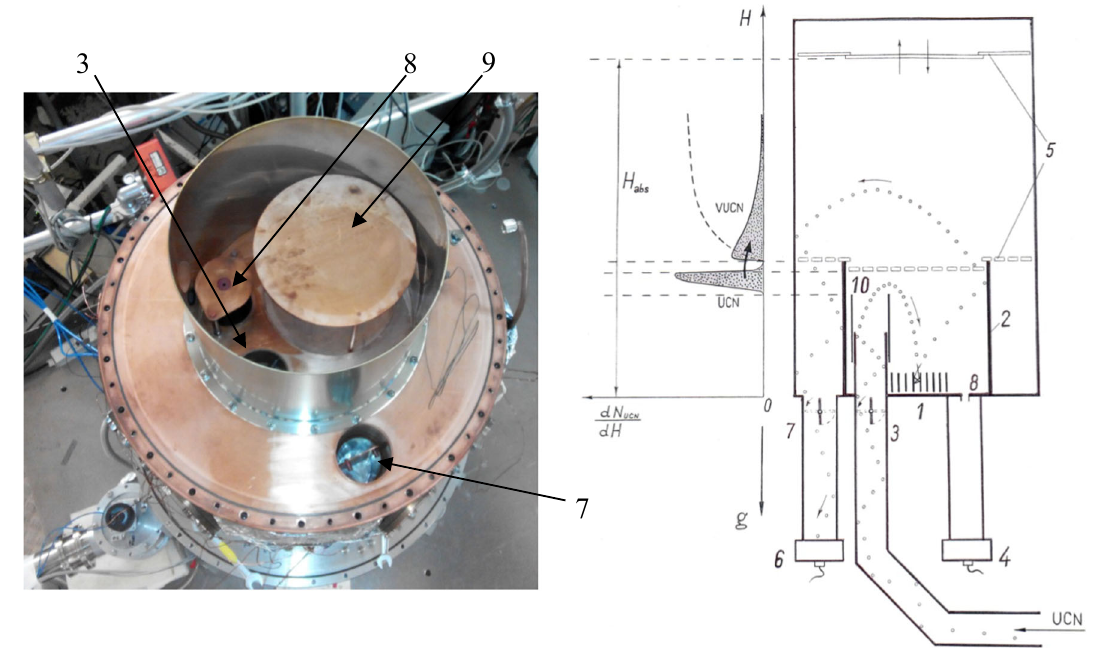
Fig. 1 Installation scheme. 1 – sample, 2 – gravitational barrier, 3 – entrance shutter, 4 – monitor, 5 – absorber, 6 – detector, 7 – exit shutter, 8 – calibration orifice, 9 – “elevator” for samples, 10 – entrance neutron guide Table 1 Physical parameters of Fomblin Y-HVAC at room temperature [30]